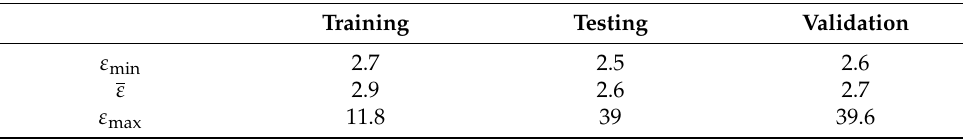
Table 6. Performance statistics for the non-dominated set.